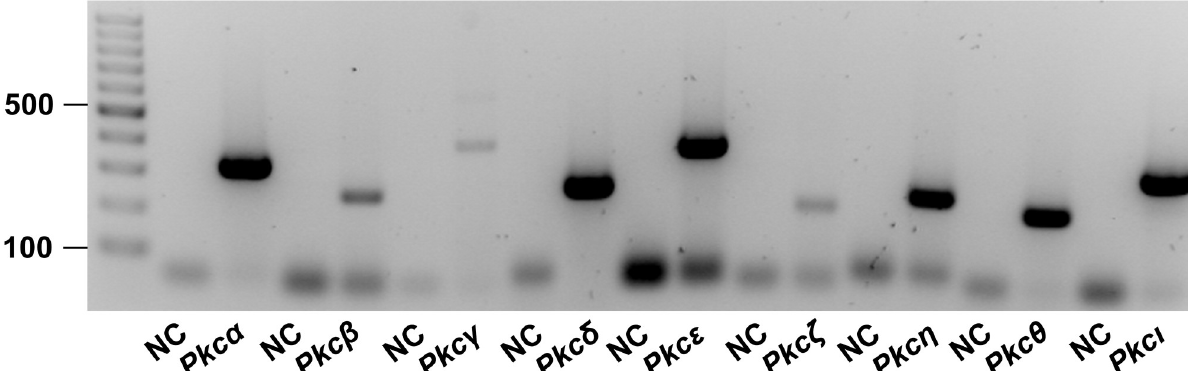
Fig 1. Expression of Pkc isoforms in UMR106 osteoblast-like cells. Original agarose gel photo showing Pkc α , - β , - γ , - δ , - ε , - z , - η , -θ or - ι specific cDNA in UMR106 cells. NC: non-template control.